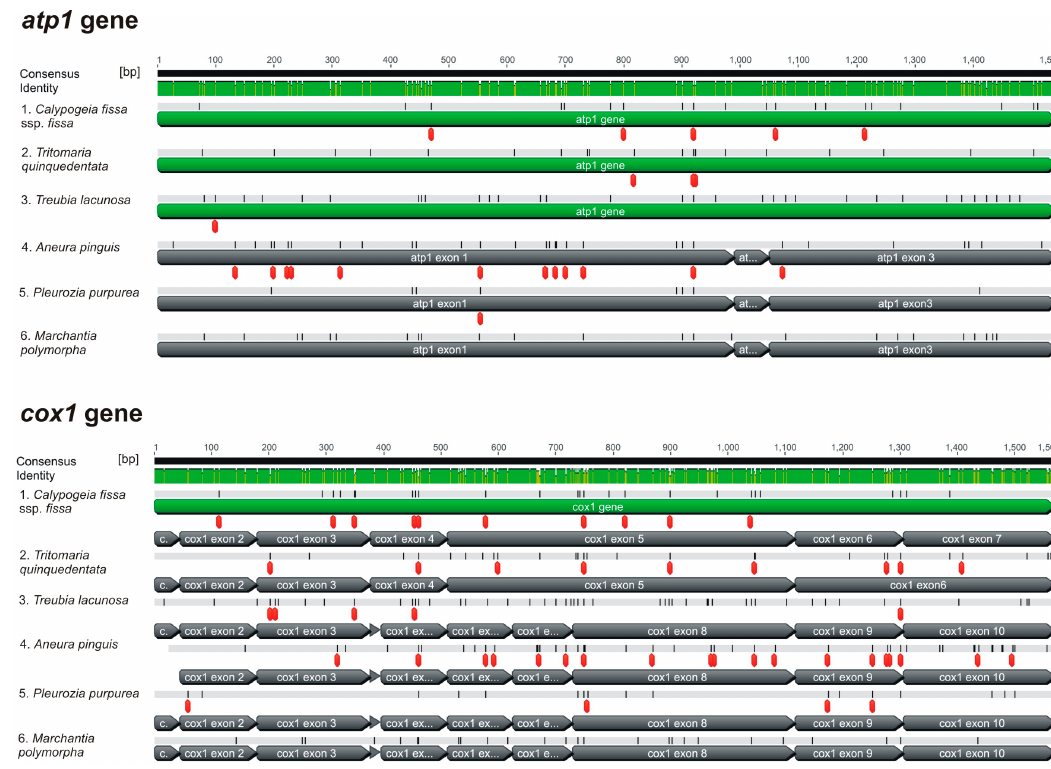
Figure 3. Occurrence of editing sites in atp1 and cox1 genes of different liverwort species (marked in